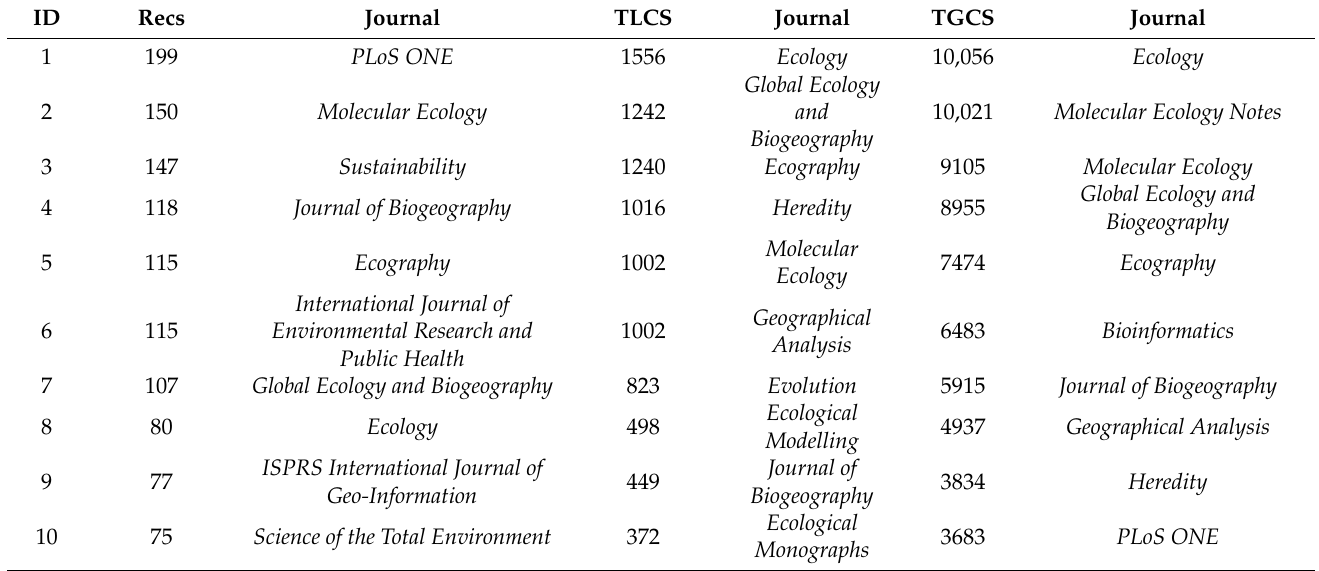
Table 2. Top ten influential journals in terms of Recs, TLCS, and